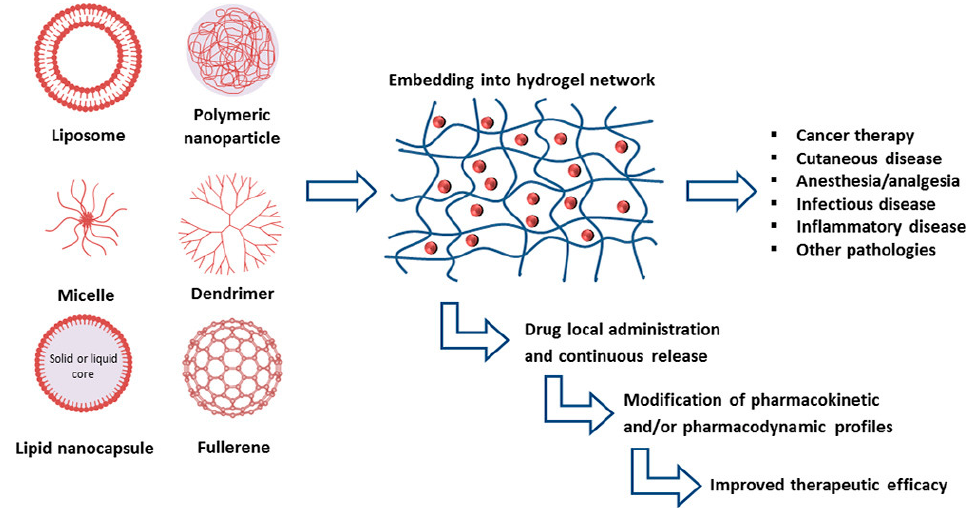
Figure 3. Advancements realized by the inclusion of various nanocarriers within hydrogels [4].